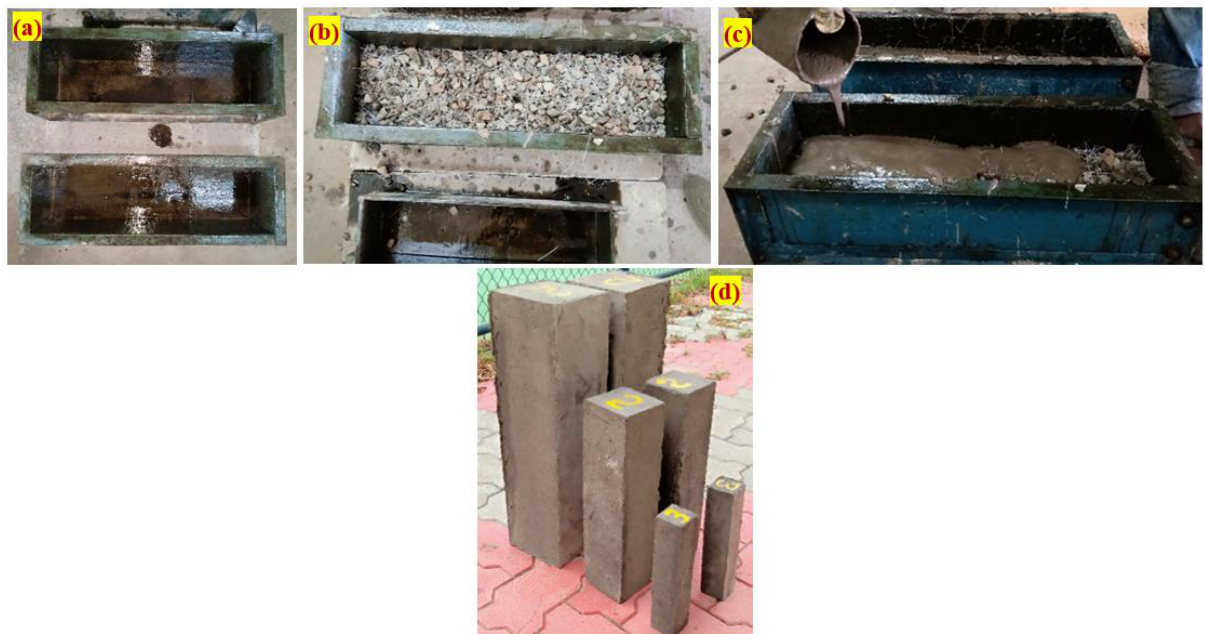
Figure 4. Casting procedure: ( a ) empty mold with oil coating; ( b ) packed fibers and aggregates; ( c ) grout injection; ( d ) demolded specimen.